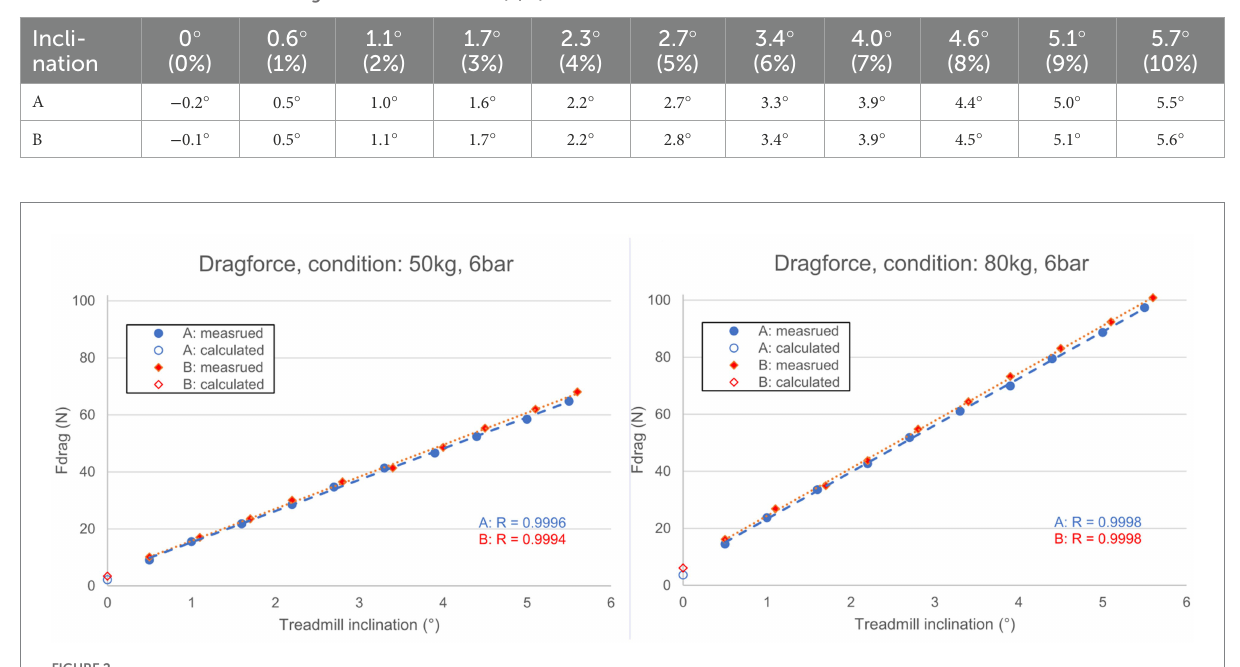
FIGURE 2 Measured and calculated drag forces, obtained from the drag test.